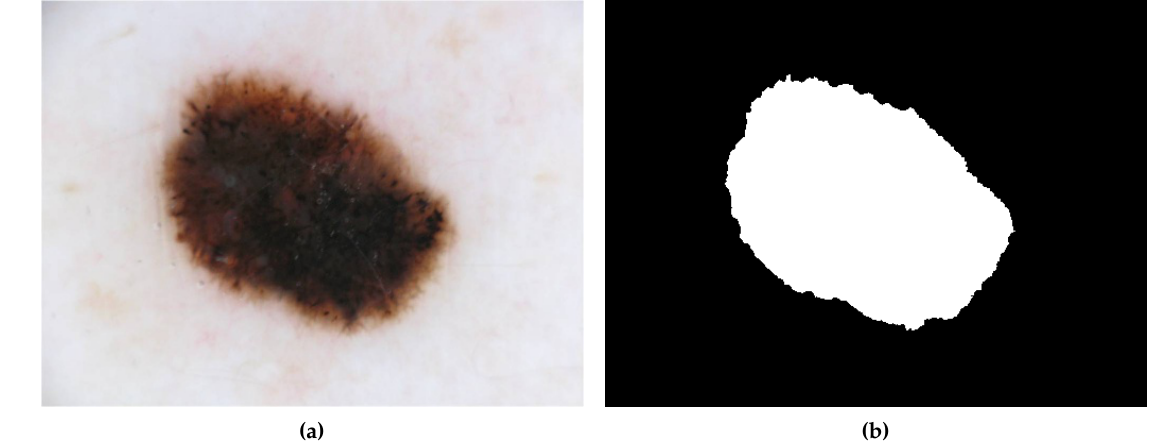
Figure 2. Database sample. ( a ) Original image; ( b ) Binary